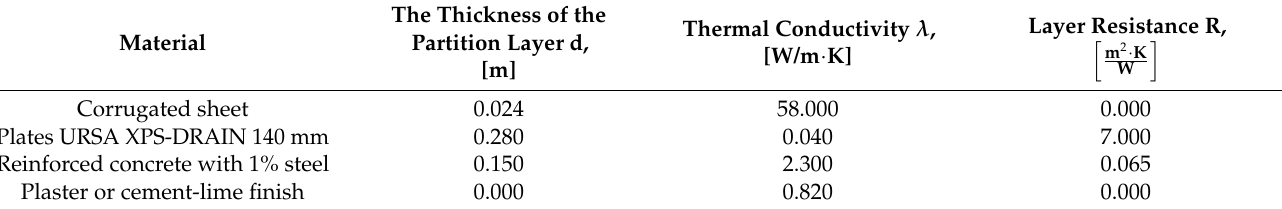
Table 5. Characteristics of the partition-flat roof.